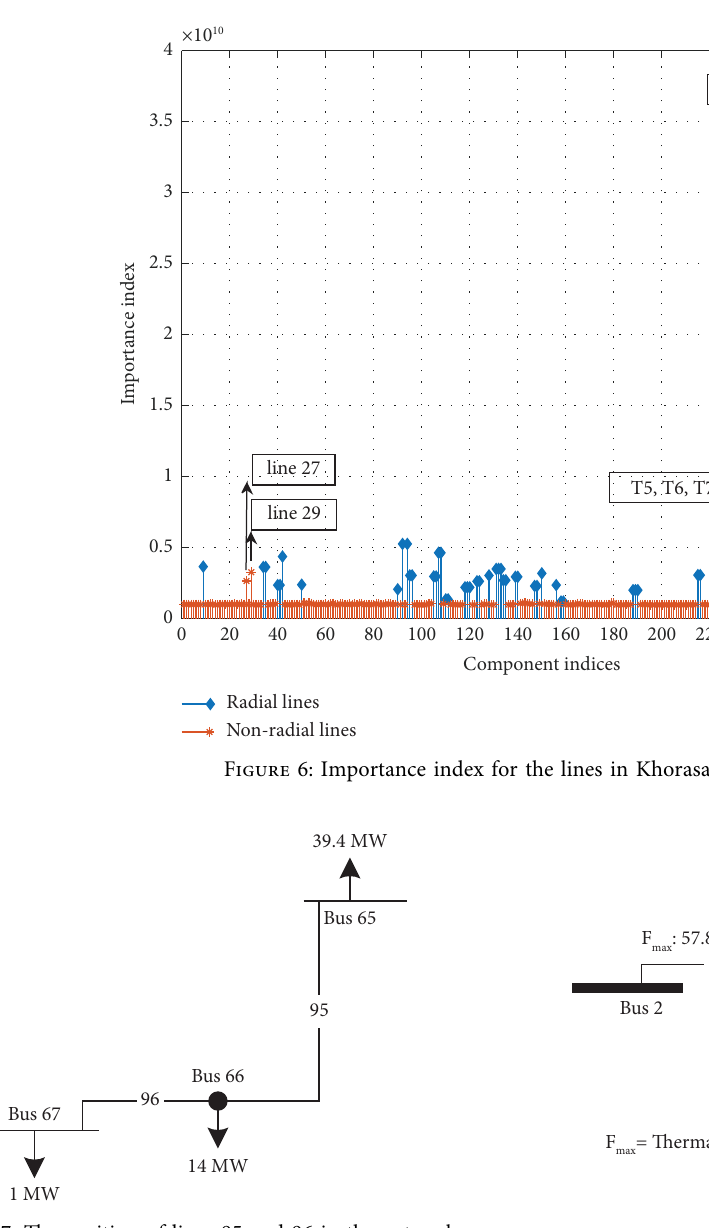
8: Te position of lines 27 and 29 in the